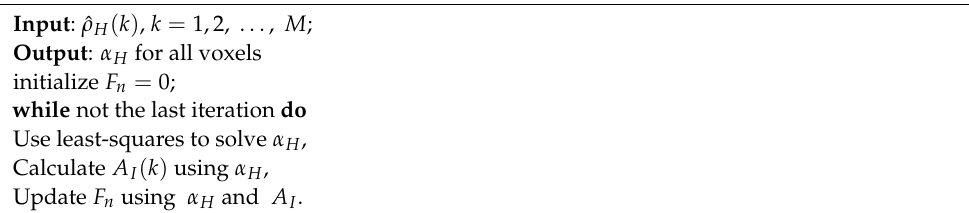
Algorithm 1. The iterative process used to update the noise figure.